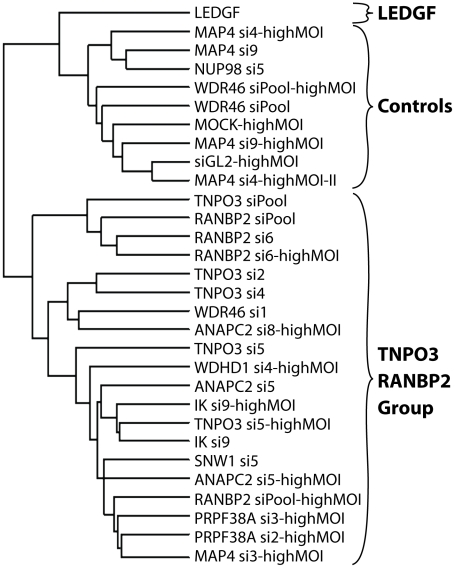
Dendrogram showing clustering of integration site data sets from knockdowns of Transportin-3, RanBP2, and several additional factors.Only sets containing at least 200 integration sites were used for the analysis. A conditional logit model was used to cluster integration sites data sets based on annotation of in or out of annotated transcription units, gene density, expression density, CpG islands, G/C content, nearby oncogenes, and local sequence features (Text S3). Sets were clustered based on their overall similarity in a pairwise analysis. The "Control" cluster is so named because it contains the Mock and siGL2 control data sets. Branch labels indicate the siRNA used for the analysis, and indicates the name of the targeted gene (e.g. TNPO3 si4). Infections were performed using enough HIV vector stock to infect 30–60% of untreated cells except where marked as “highMOI” where 90–100% of untreated cells were infected.